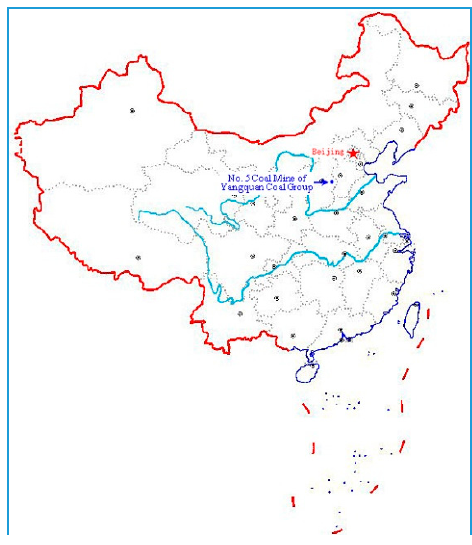
Figure 1. Coal mine site. Table 1. Geomechanical parameters of the roof and floor.